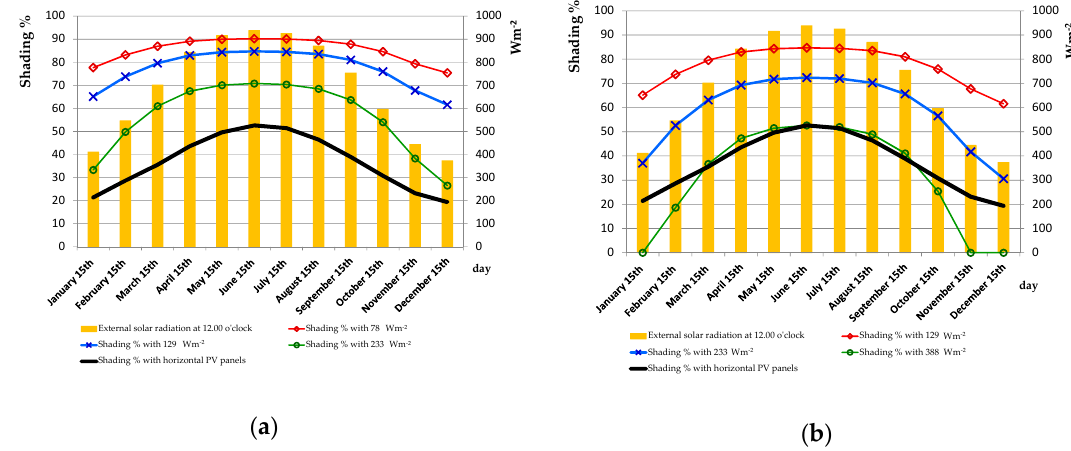
( b ) Figure 9. ( a ) Percentage of shading in the photovoltaic greenhouse to guarantee that the minimum radiation threshold that is necessary for the plants is met; ( b ) percentage of shading in the photovoltaic greenhouse to guarantee that the maximum threshold that is necessary for the plants is